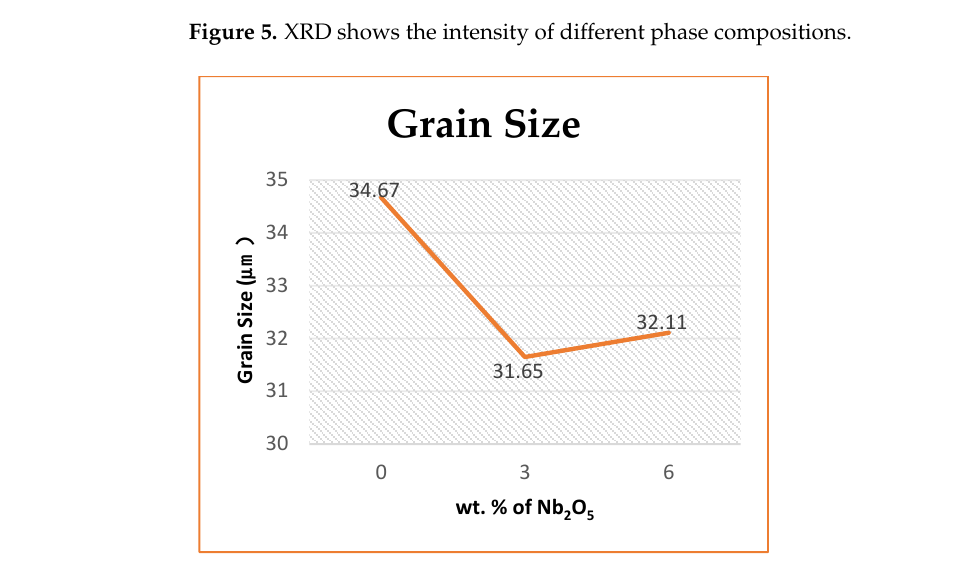
Figure 6. The graph shows the grain size.